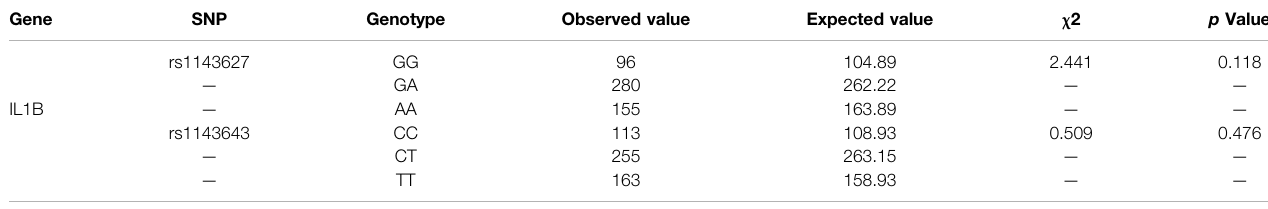
TABLE 2 | Hardy-Weinberg Equilibrium of 1LIB Gene Polymorphisms. Gene SNP